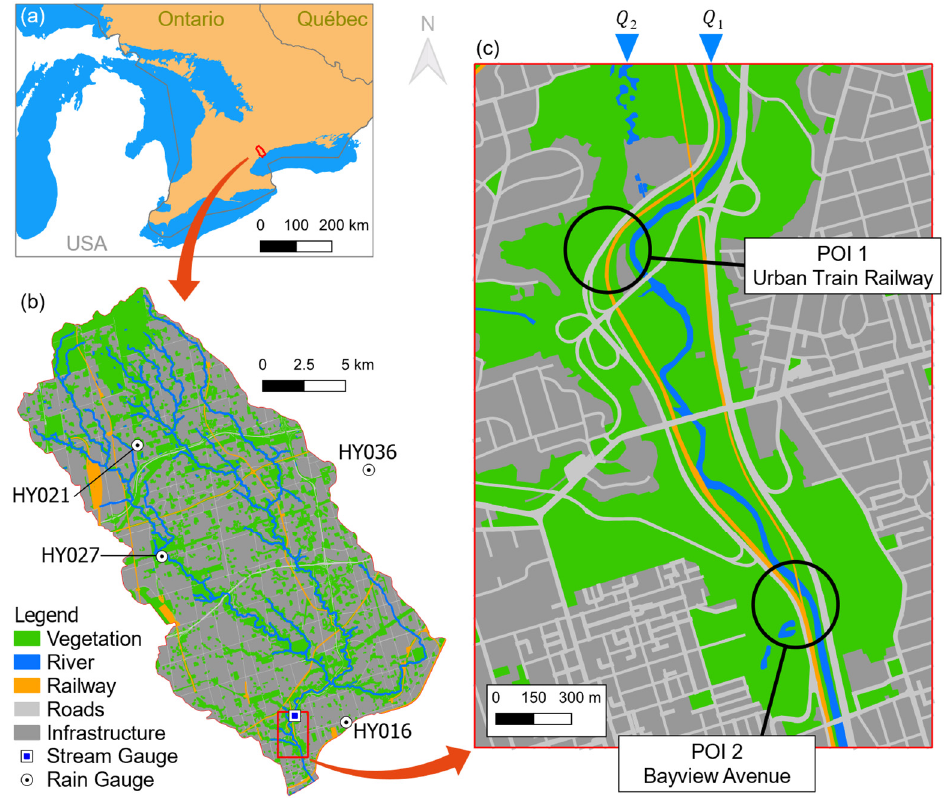
Figure 1. Representation of the Don River Basin in terms of ( a ) its location, ( b ) its land coverage, and ( c ) its region prone to flash floods. Adapted from [19].